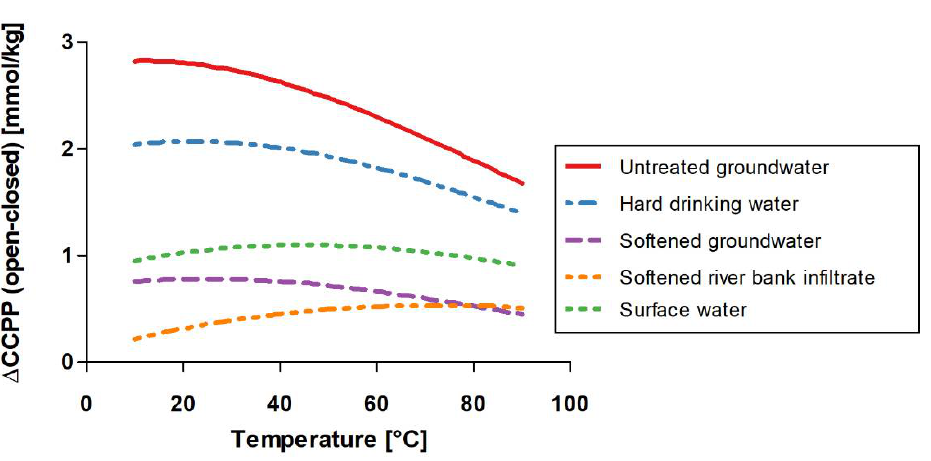
Figure 3. Difference in CCPP between open and closed systems as a function of temperature (0–90 ◦ C) calculated for five water types. Untreated groundwater: Frederiksberg. Hard drinking water: Thorsbro. Softened drinking water: Brøndbyvester. Softened riverbank infiltration: Lekkerkerk. Surface water: